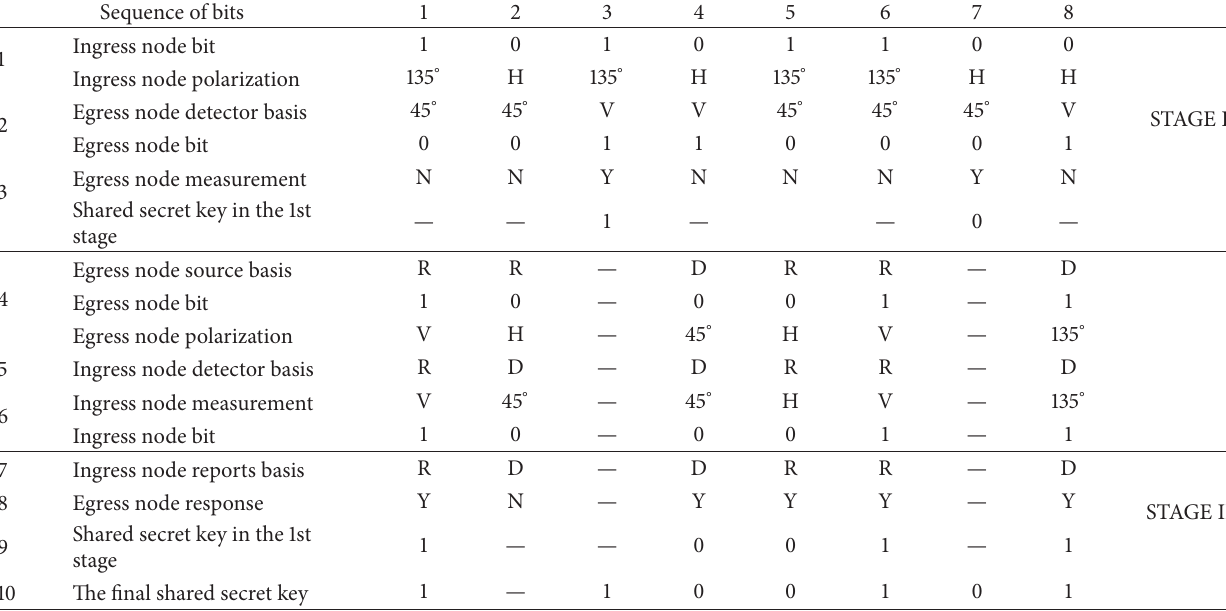
Table 4: An 8-bit sample for two-stage QKD protocol.